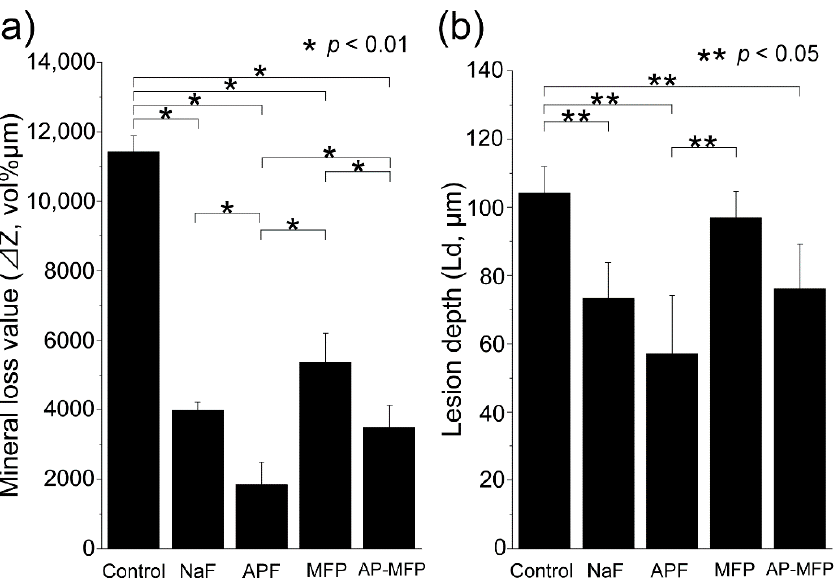
Figure 5. ( a ) Graphical representation of the mineral loss value ( Δ Z, n = 8, * p < 0.01) after the acid challenge. For each sample, five sites were measured from the vicinity of the surface to the healthy enamel in a 50 × 300 μ m region. All eight samples were measured and the mean ± SD is shown; ( b ) graphical representation of the lesion depth (Ld, n = 8, ** p < 0.05) after the acid challenge. From the surface prior to the demineralization experiment, the depth of demineralization was determined up to a site showing 95% healthy enamel. For each sample, five sites were measured. All eight samples were measured and the mean ± SD is shown.